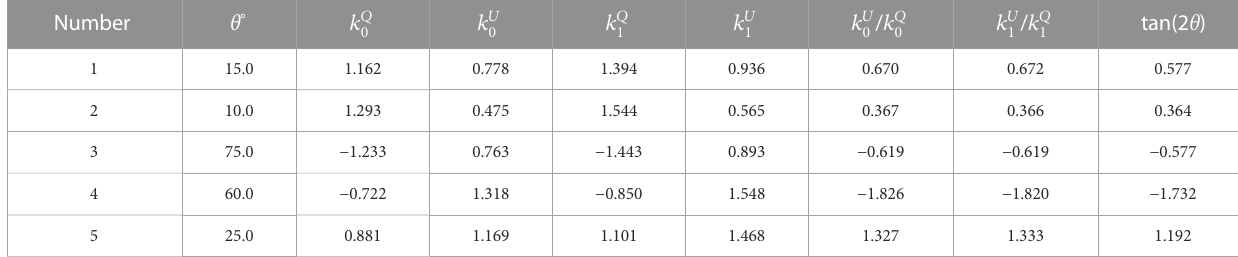
TABLE 3 Derived fi tting parameters for multiple point sources with unknown polarization direction when r = 0.023.